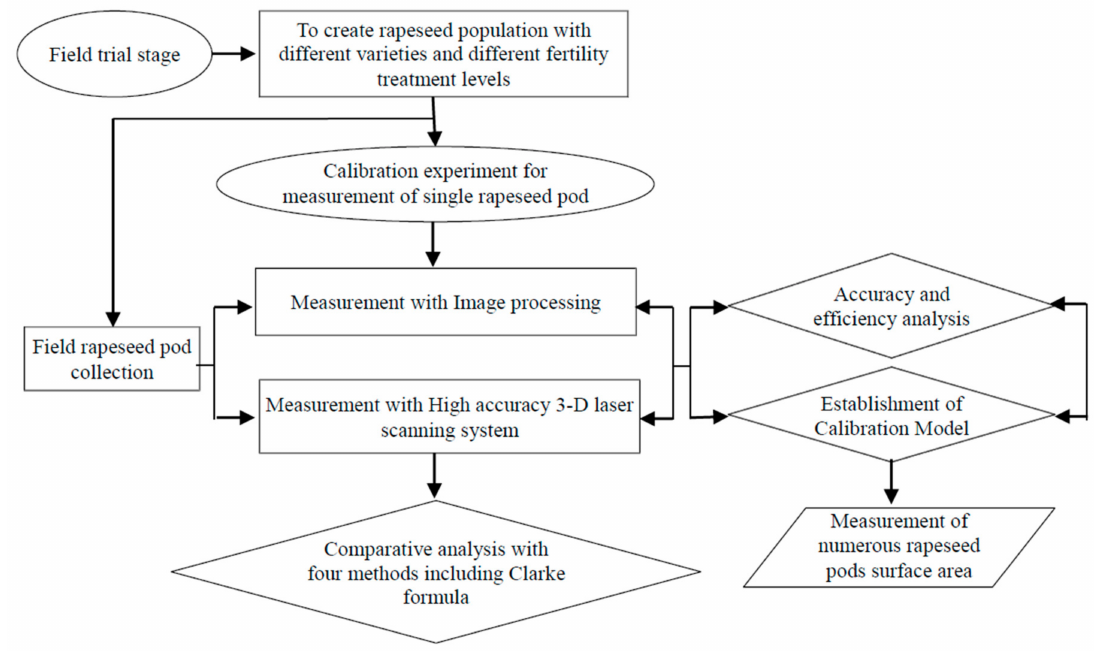
Figure 2. Research flowchart of the proposed methodology for measuring the rapeseed pod surface